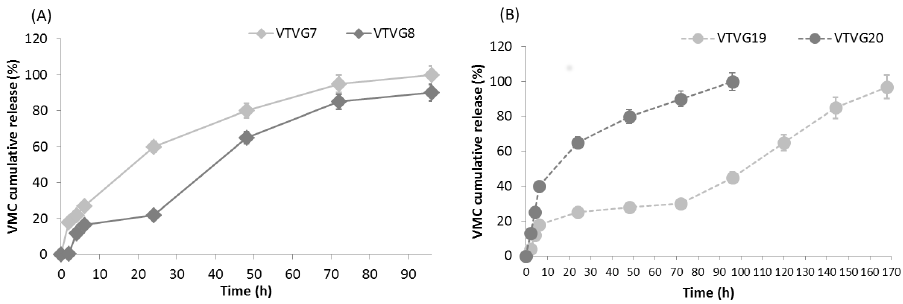
Figure 6. In vitro release study of VTVGs incorporating VMC; data are expressed as percentage of VMC released vs. time ( n = 3). VTVG formulation was based on PLA-PCL polymer ( A ) and PLGA polymer ( B ).